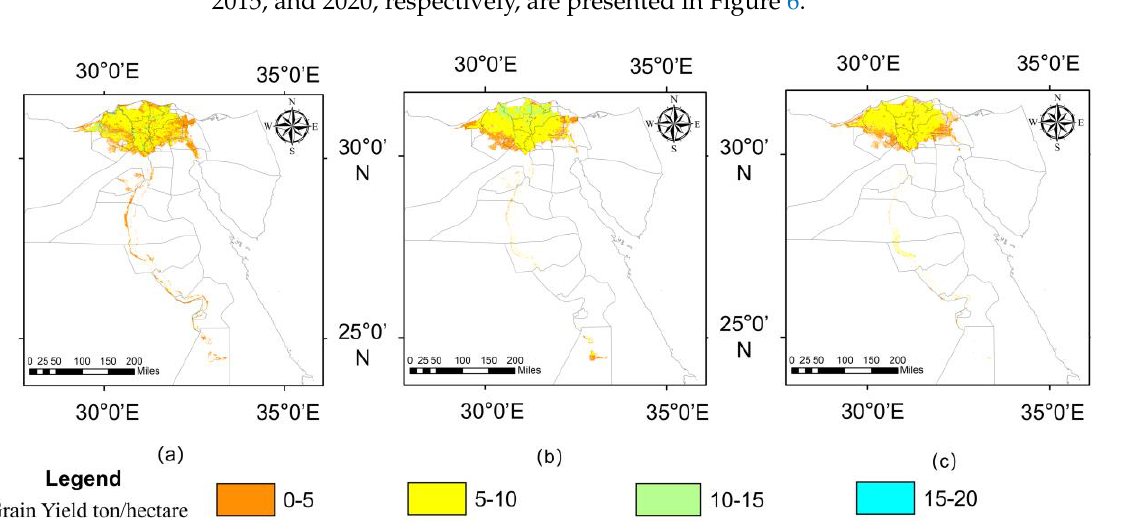
Figure 6. Estimated results of grain yield in Egypt in ( a ) 2010, ( b ) 2015, and ( c ) 2020 using the CASA model.